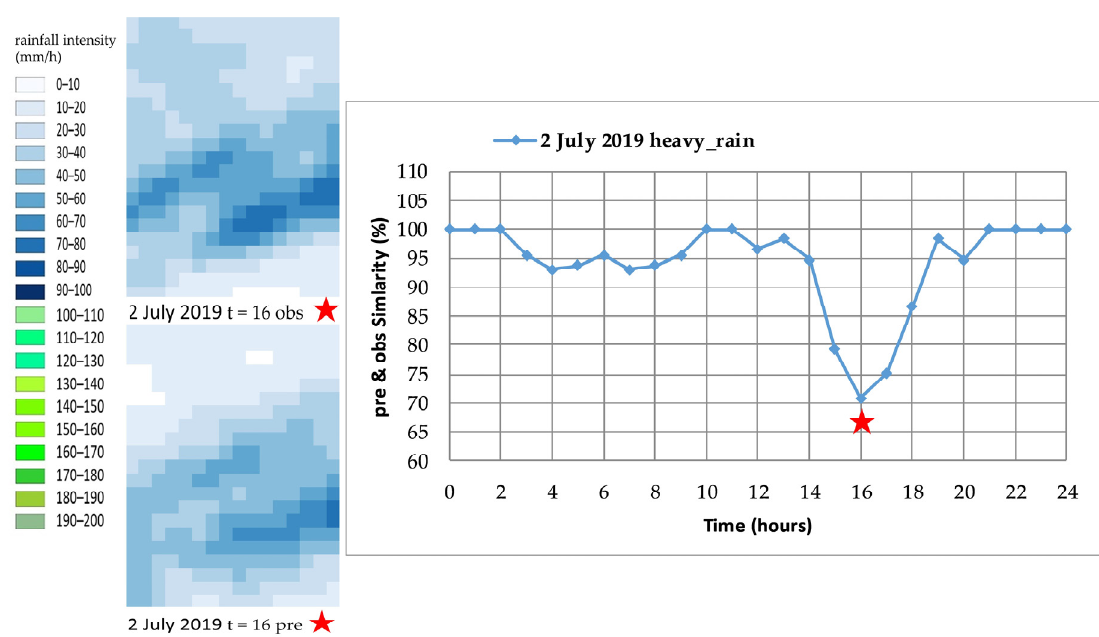
Figure 9. Similarity values of measured (obs) and predicated (pre) rainfall images in 24-h duration.